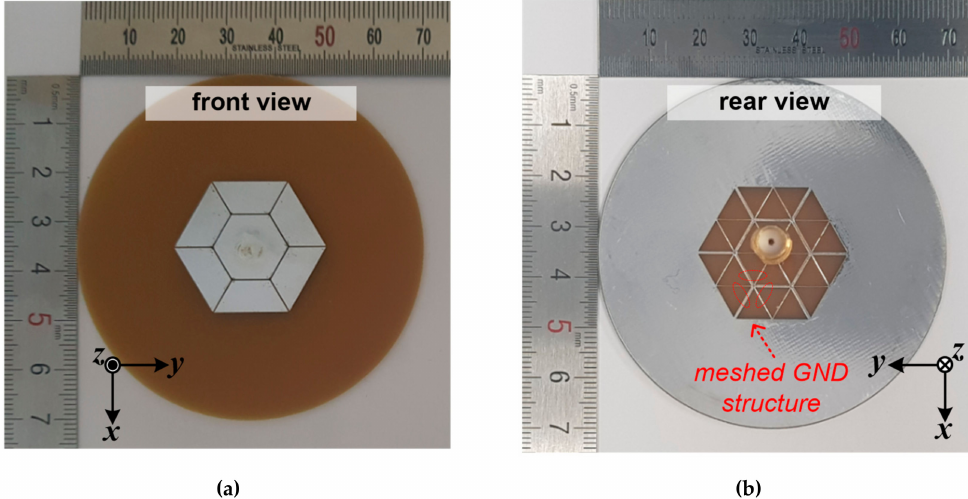
Figure 4. The fabricated antenna prototype: ( a ) front view and ( b ) rear